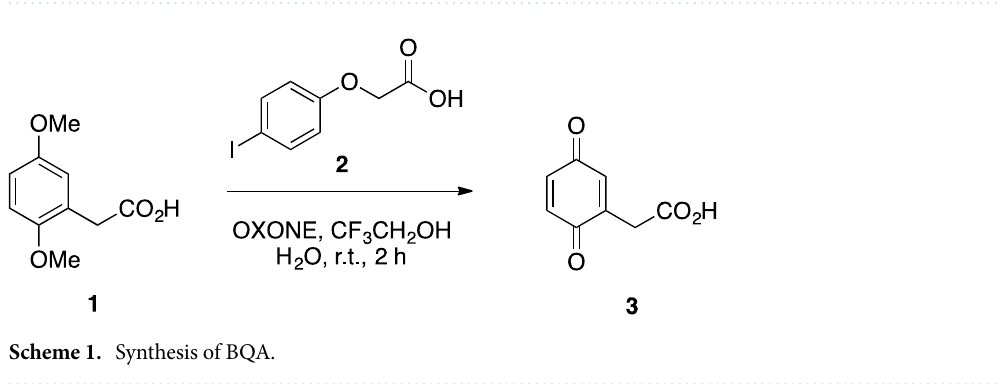
Figure 4. 13 C spectroscopy of a urine sample: from bottom to top, spectra acquired before alkalinisation, then after 1’, 16 h and 14d, are shown. Loss of signal intensity for HGA peaks (marked with arrows) down to the noise level is apparent.